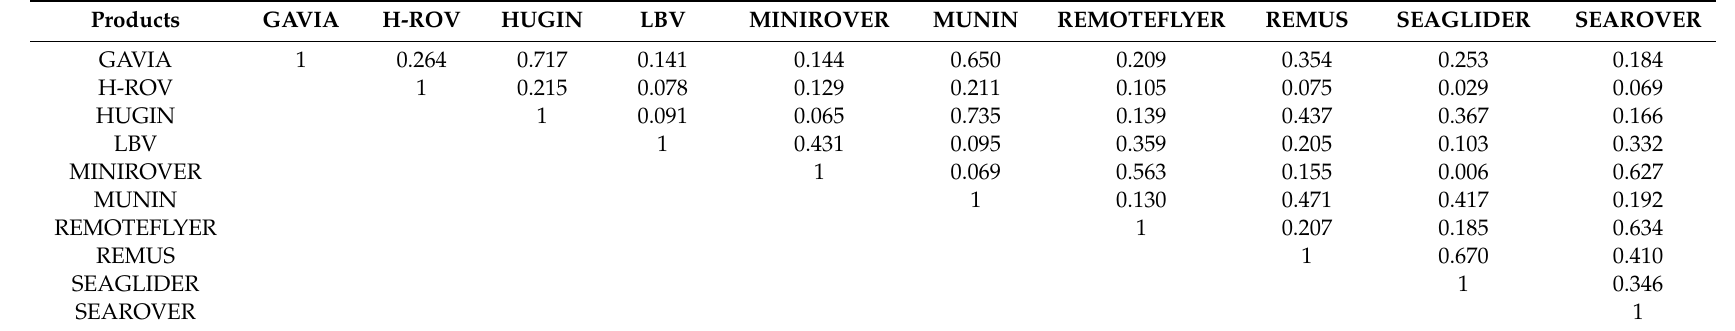
Table 8. The cosine similarity values between